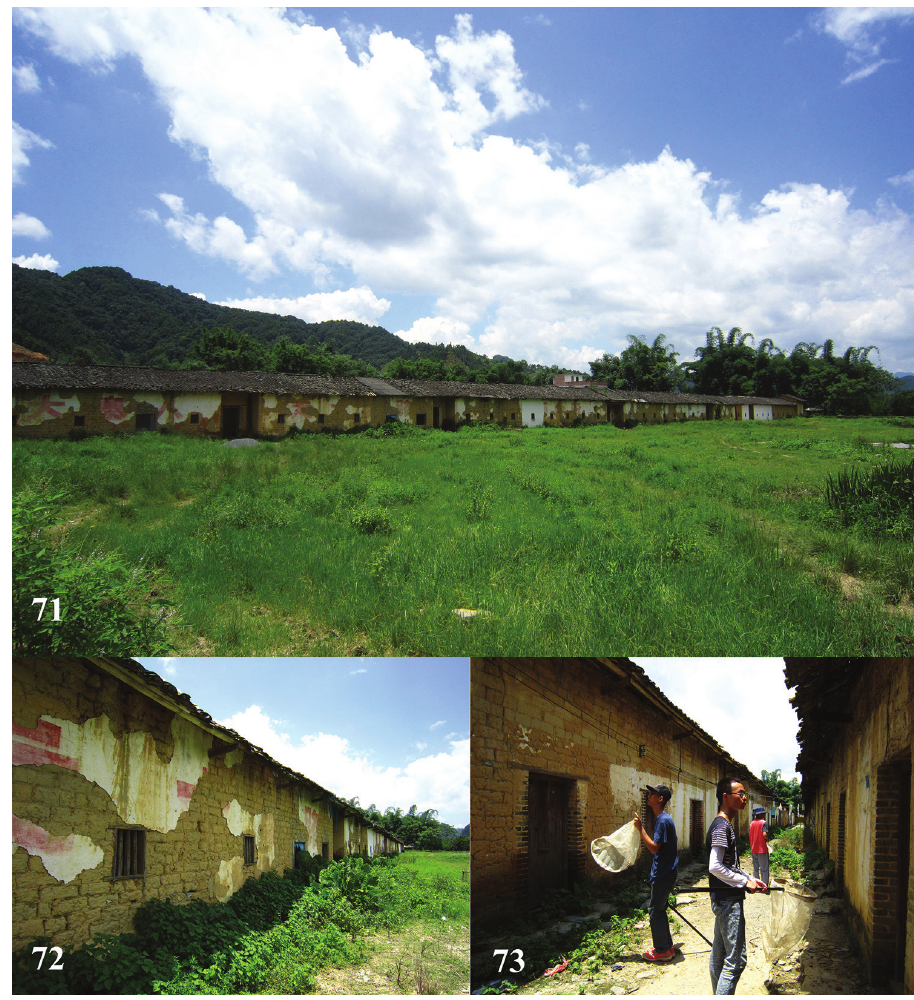
Figures 71–73. Habitats of Leucospis femoricincta Bouček in